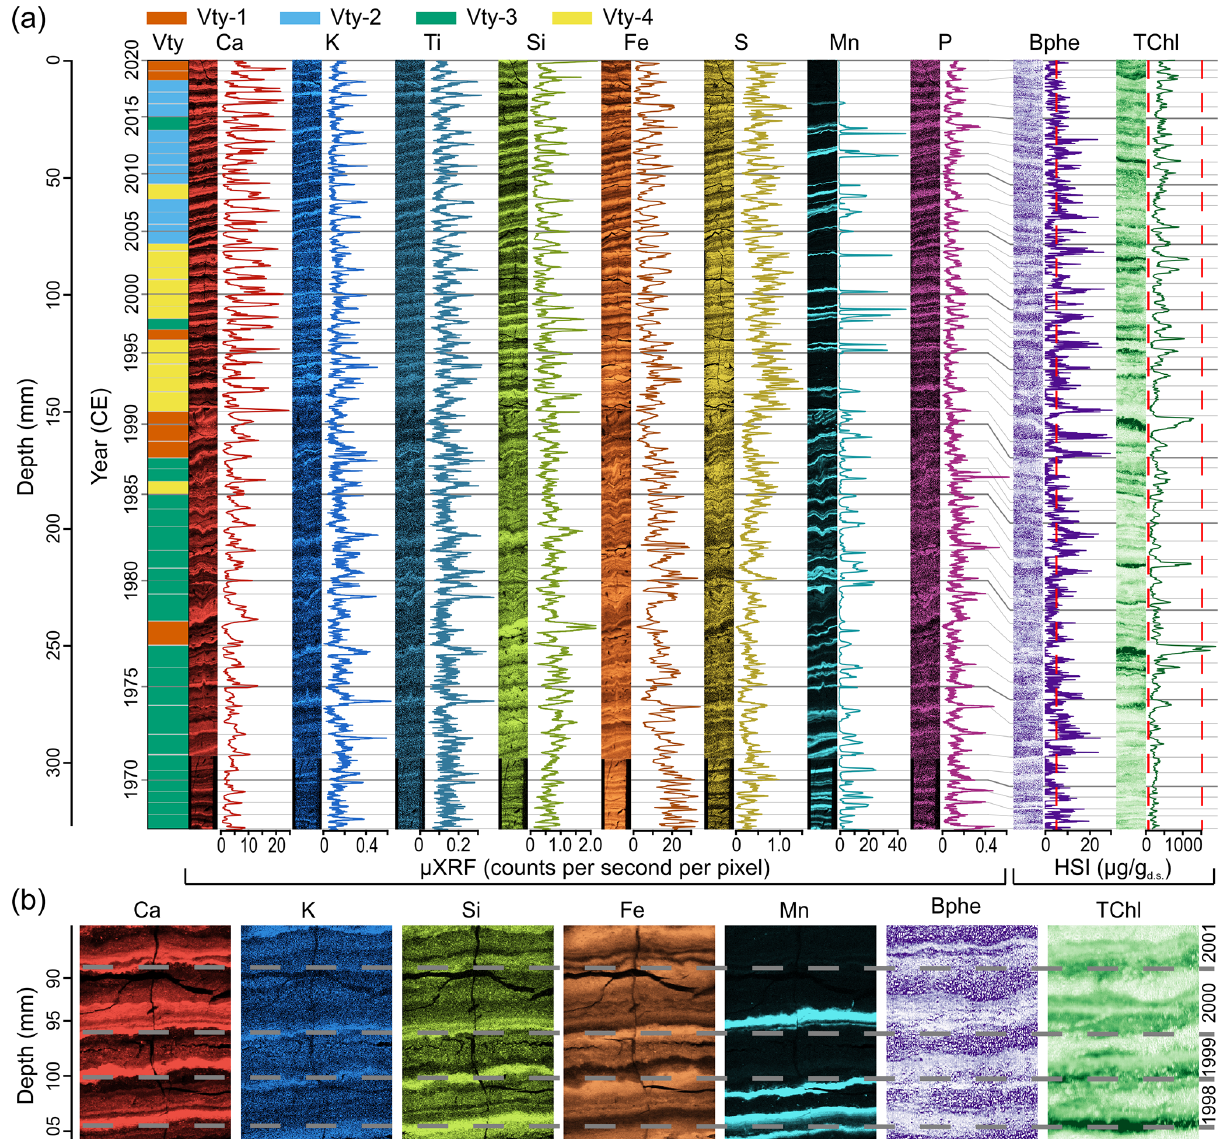
Figure 3. High-resolution geochemical data obtained from imaging spectroscopy (µXRF = micro X-ray fluorescence, HSI = hyperspectral imaging). (a) Composite sequence shown as both spatial maps and down-core profiles. Varve boundaries are shown as horizontal lines. Varve types (Vtys) are plotted on the left side (see Sect. 3.3 for an explanation of Vty). µXRF data are from resin-embedded sediment slabs, data from 1966–1990 are from the 2012 core, and data from 1991–2019 are from the 2020 core. HSI data are from the wet 2020 core. Red dashed lines indicate the calibration range for pigment concentrations obtained using HSI. (b) Close-ups of spatial distribution of elements and pigments in four